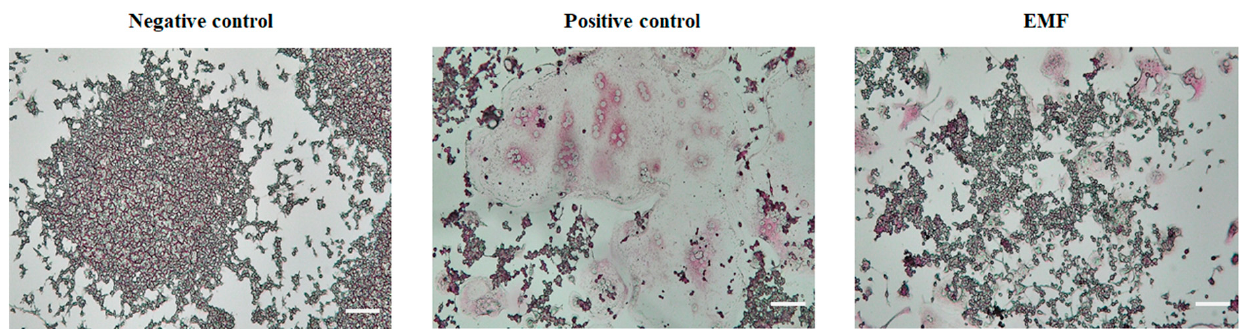
Figure 2. EMF exposure suppresses RANKL-mediated osteoclast differentiation. TRAP activity assay in Raw 264.7 cells differentiated into osteoclasts for 4 days in differentiation media (with RANKL) with or without EMF exposure. Images were acquired at 100× magnification. EMF, electromagnetic field; LDH, lactate dehydrogenase. Negative control, cells grown in growth media (undifferentiated); positive control, cells grown in differentiation media (with RANKL); EMF, cells grown in differentiation media (with RANKL) with EMF exposure.